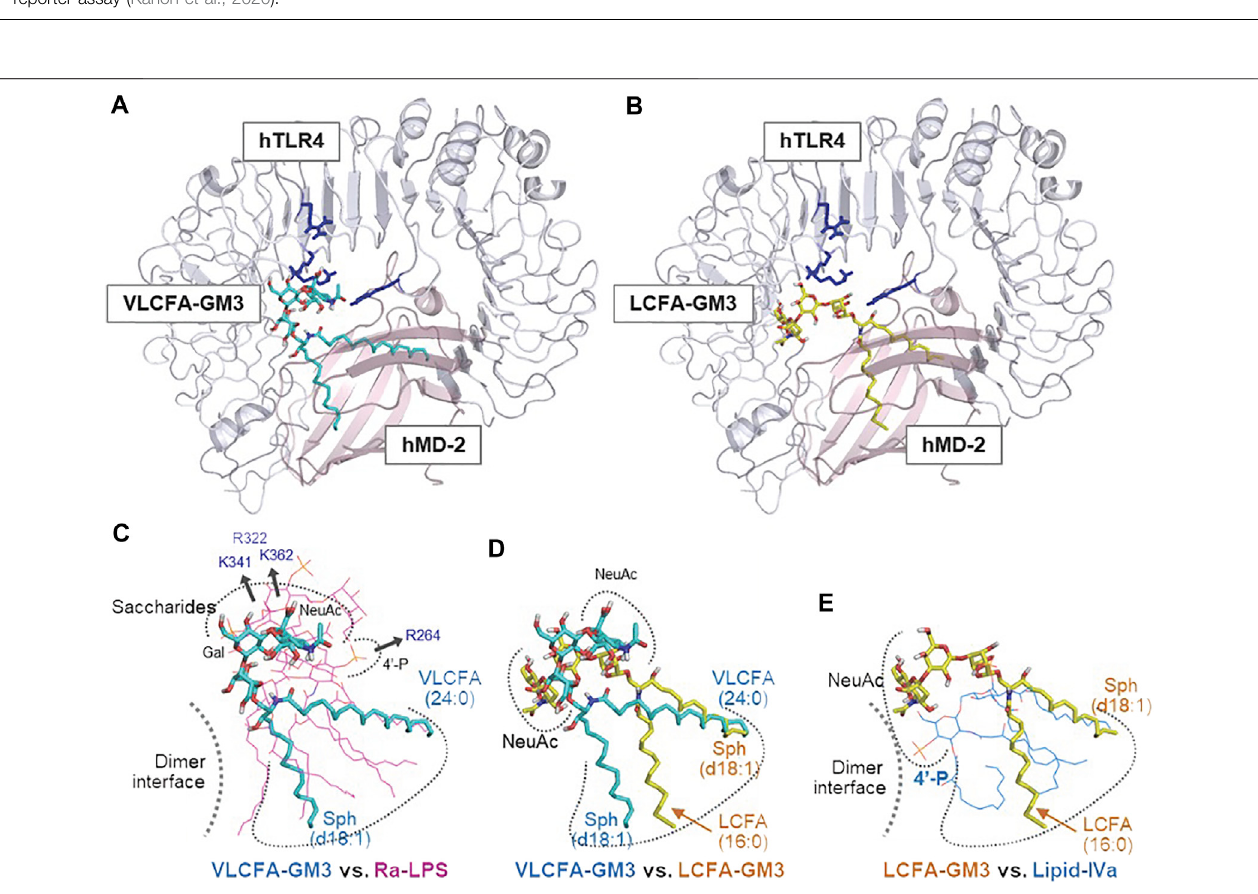
FIGURE 5 | Enhancement or suppression of human TLR4 activation by GM3 species. Ligand-macromolecular docking analysis: Docking model of GM3 24:0 (A) and16:0 (B) bindingtohumanTLR4/MD2complex.BasicresiduesofTLR4arecoleredinblue.SuperpositionofGM324:0vs.Ra-LPS (C) ,GM324:0vs.GM316:0 (D) , and GM316:0vs. lipidIVa (E) .Bindingmode oflipidIVa (antagonist) differedfrom thatofLPS;itinvolvedreverseorientationof4 ′ -phosphateand acylchains,whichmay inhibit TLR4/MD-2 dimer formation (E) . Binding mode of GM3 16:0 was opposite that of GM3 24:0; it involved reverse orientation of acyl chains to MD-2 hydrophobic pockets (D) , resulting in suppression of TLR4 activation (E) (Kanoh et al., 2020).